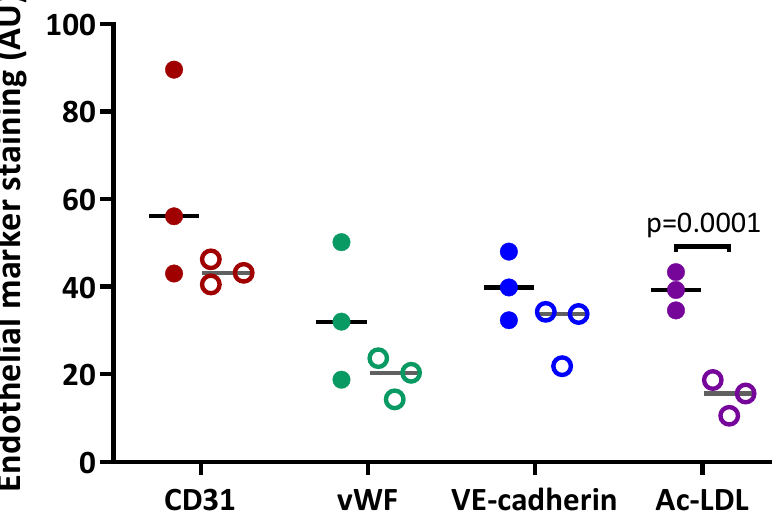
Figure 6. Quantification of the expression of specific endothelial markers in PAECs. Expression of CD31, vascular endothelium cadherin (VE-cadherin) and von Willebrand factor (vWF)and uptake of acetylated low-density lipoproteins (Ac-LDL) in PAECs from 3 different patients were quantified in early subcultures ( full circles ) and advanced subcultures ( open circles ).